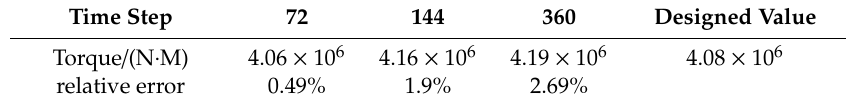
Table 4. Rotor torque calculated using different time step sizes averaged over one revolution.